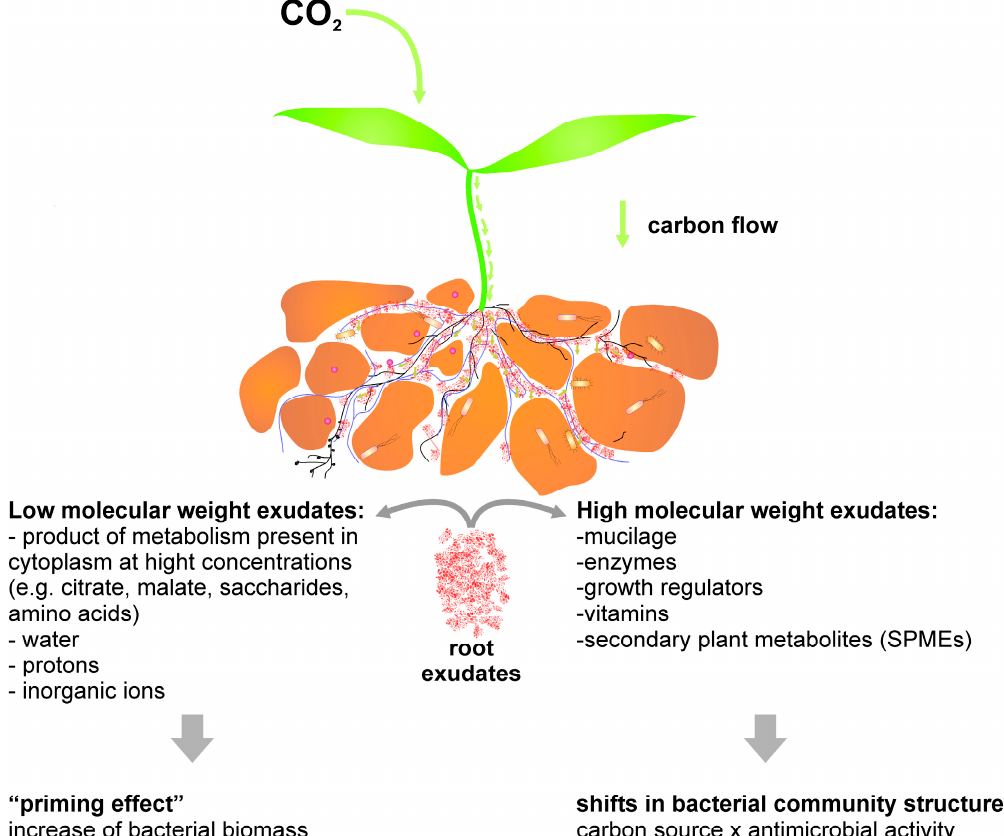
Figure 1. Carbon flow in plants—carbon dioxide is assimilated by plants and used for synthesis of metabolites, which are used in anabolism or released by rhizodeposition into the rhizosphere. Root exudates further affect soil properties and residing microbiota.